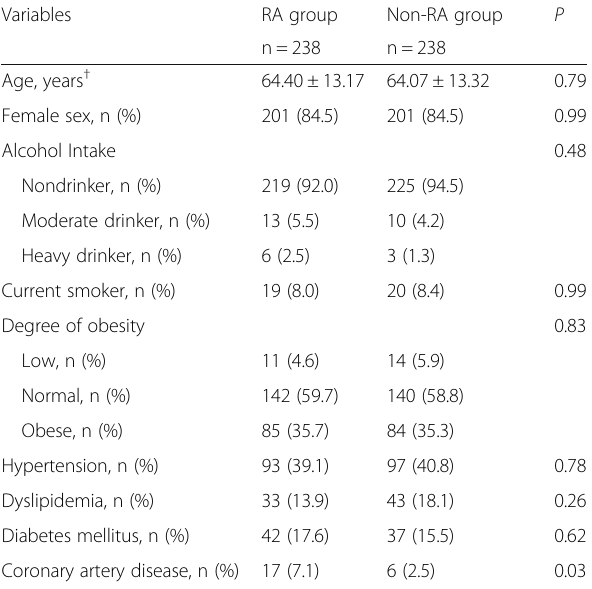
Table 3 Baseline characteristics of the study participants after propensity